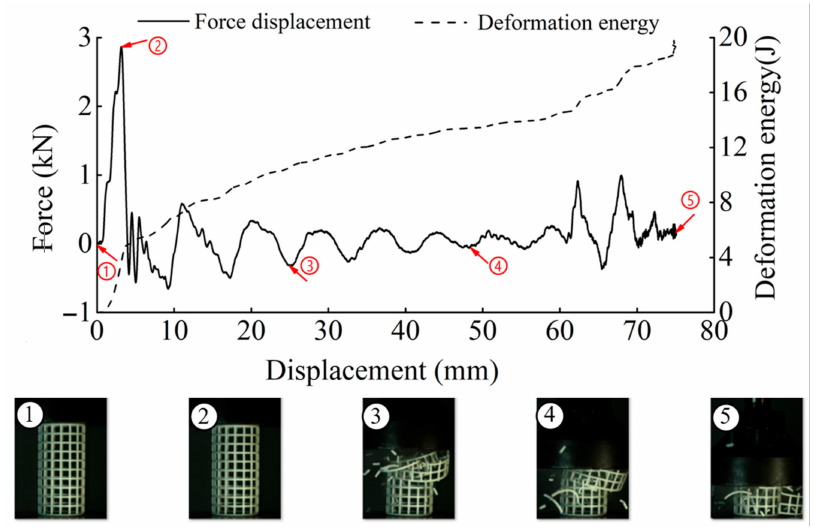
Figure 15. The results of dynamic tests of CSHT0 (1–5 stages of deformation during the dynamic compressive test).